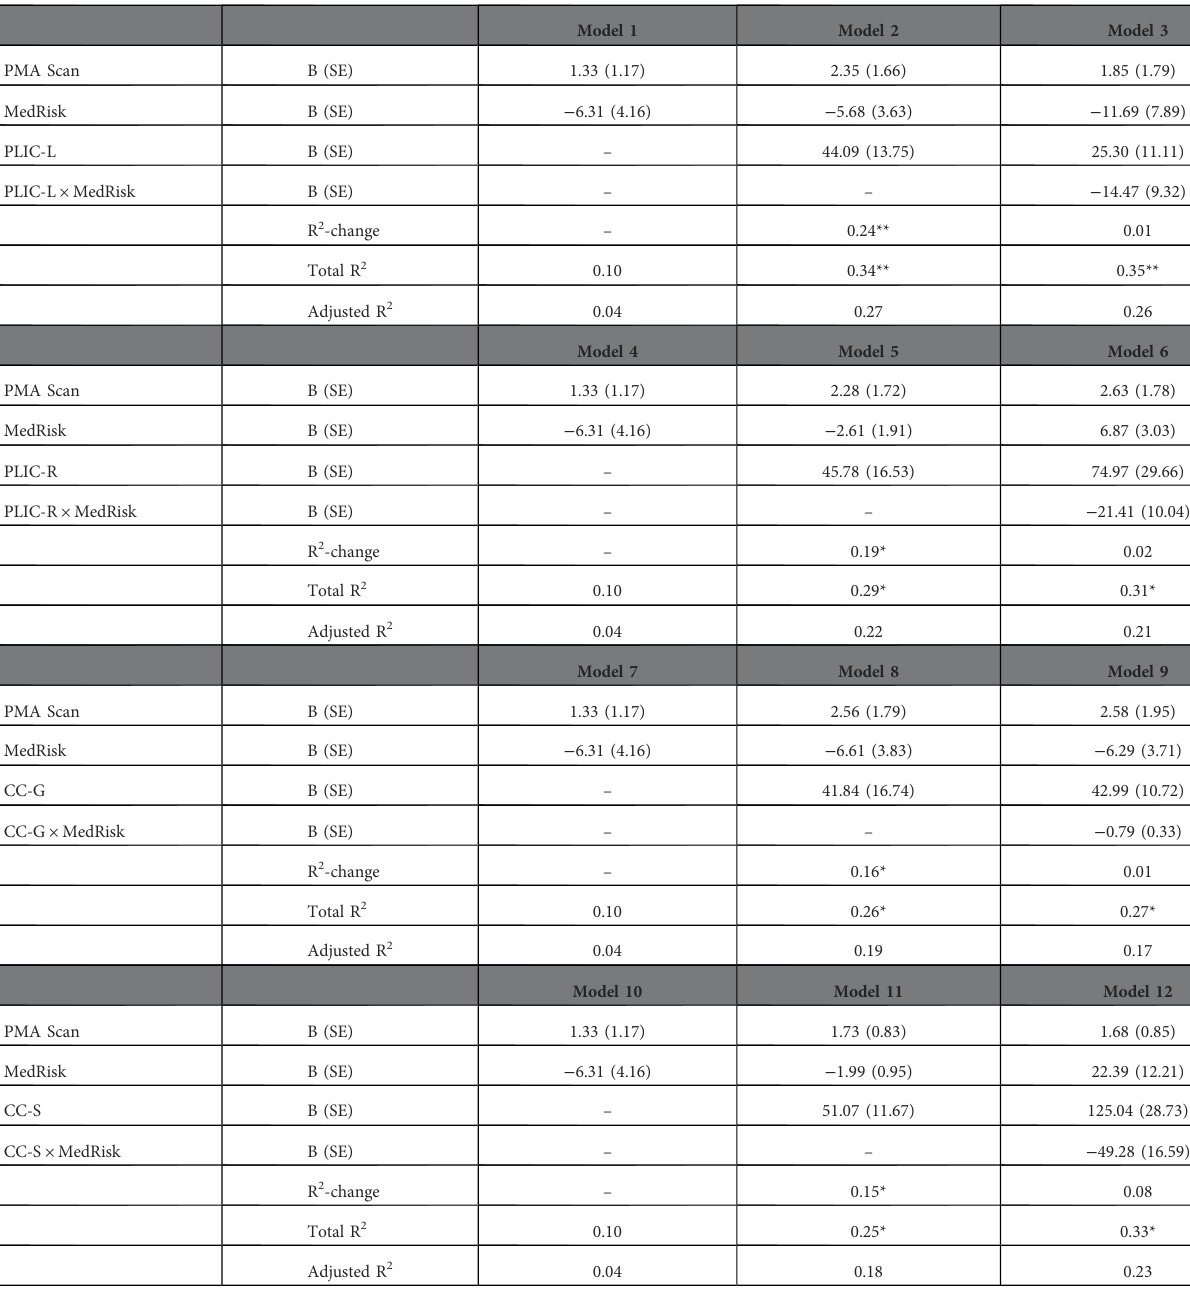
TABLE 2 Prediction of bayley-III motor scores at 2 years of corrected-age from tract MK values of PLIC and corpus callosum beyond covariates of post menstrual age at DKI scan (PMA scan) and neonatal medical complications